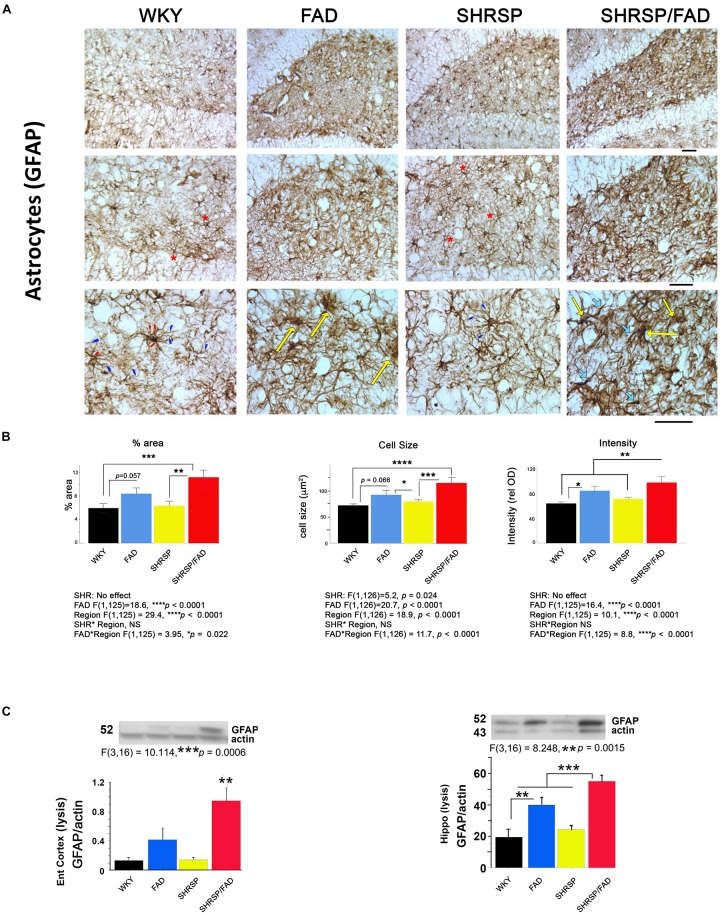
Astrogliosis is augmented in SHRSP/FAD rats. (A) Micrographs show immunostaining of brain sections for the astrocytic antigen GFAP. In WKY rats, soma generally extended thick primary branches (red arrowheads), from which multiple secondary and tertiary processes (blue arrowheads) diverged with star-shaped soma typical (red asterisks) of quiescent astrocytes. There was increased GFAP staining throughout the hilus (similar to other regions, not shown) in SHRSP/FAD rats, manifested by hypertrophied soma (yellow arrows) and extended thickened and dense processes (thick light blue arrows) with fewer thin, secondary and tertiary processes, consistent with an activated state. (B) Quantitative image analysis showed that, percentage area of GFAP staining was significantly elevated in SHRSP (p = 0.057) and SHRSP/FAD (p = 0.001) rats when compared with WKY, and in SHRSP/FAD rats when compared with FAD (p = 0.005). Two-way ANOVA (region × SHRSP × FAD) revealed significant main effects for all variables (p < 0.0001), due to a robust increase in GFAP staining in the hilus of FAD rats relative to plaque-sparse regions. GFAP staining intensity was increased further in the hilus of SHRSP/FAD rats (p < 0.006). In SHRSP/FAD rats, however, all variables, including cell size, percentage area stained and GFAP staining intensity, were significantly elevated, compared to WKY and SHRSP rats. (C) The lower two panels show representative western blot gels from experiments measuring GFAP protein in the lysis fraction of tissue lysates from the entorhinal cortex and hippocampus. One-way ANOVA showed a significant effect of strain on GFAP protein levels in the entorhinal cortex (p = 0.006) and hippocampus (p = 0.0015) and post hoc analysis indicated that GFAP protein levels were significantly elevated in entorhinal cortex and hippocampal tissue from SHRSP/FAD rats, compared to all other groups. GFAP was also significantly elevated in the hippocampus of FAD rats, compared to WKY. Data represent means ± SEM. ∗p < 0.05, ∗∗p < 0.01, ∗∗∗p < 0.001